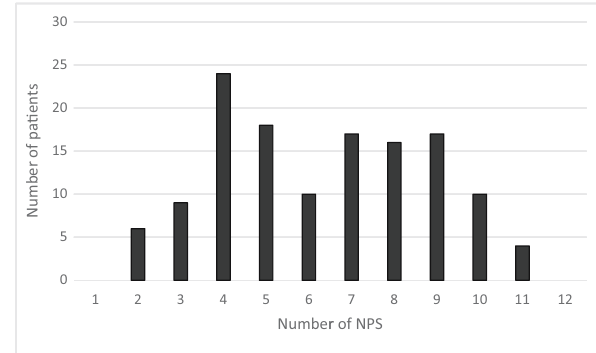
Figure 1: Frequency of